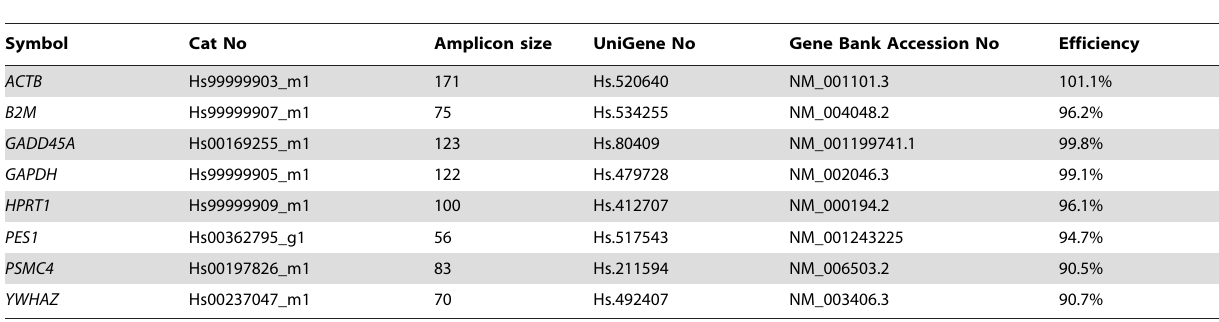
Table 2. Details of primers for evaluated genes and RT-qPCR amplification efficiencies.